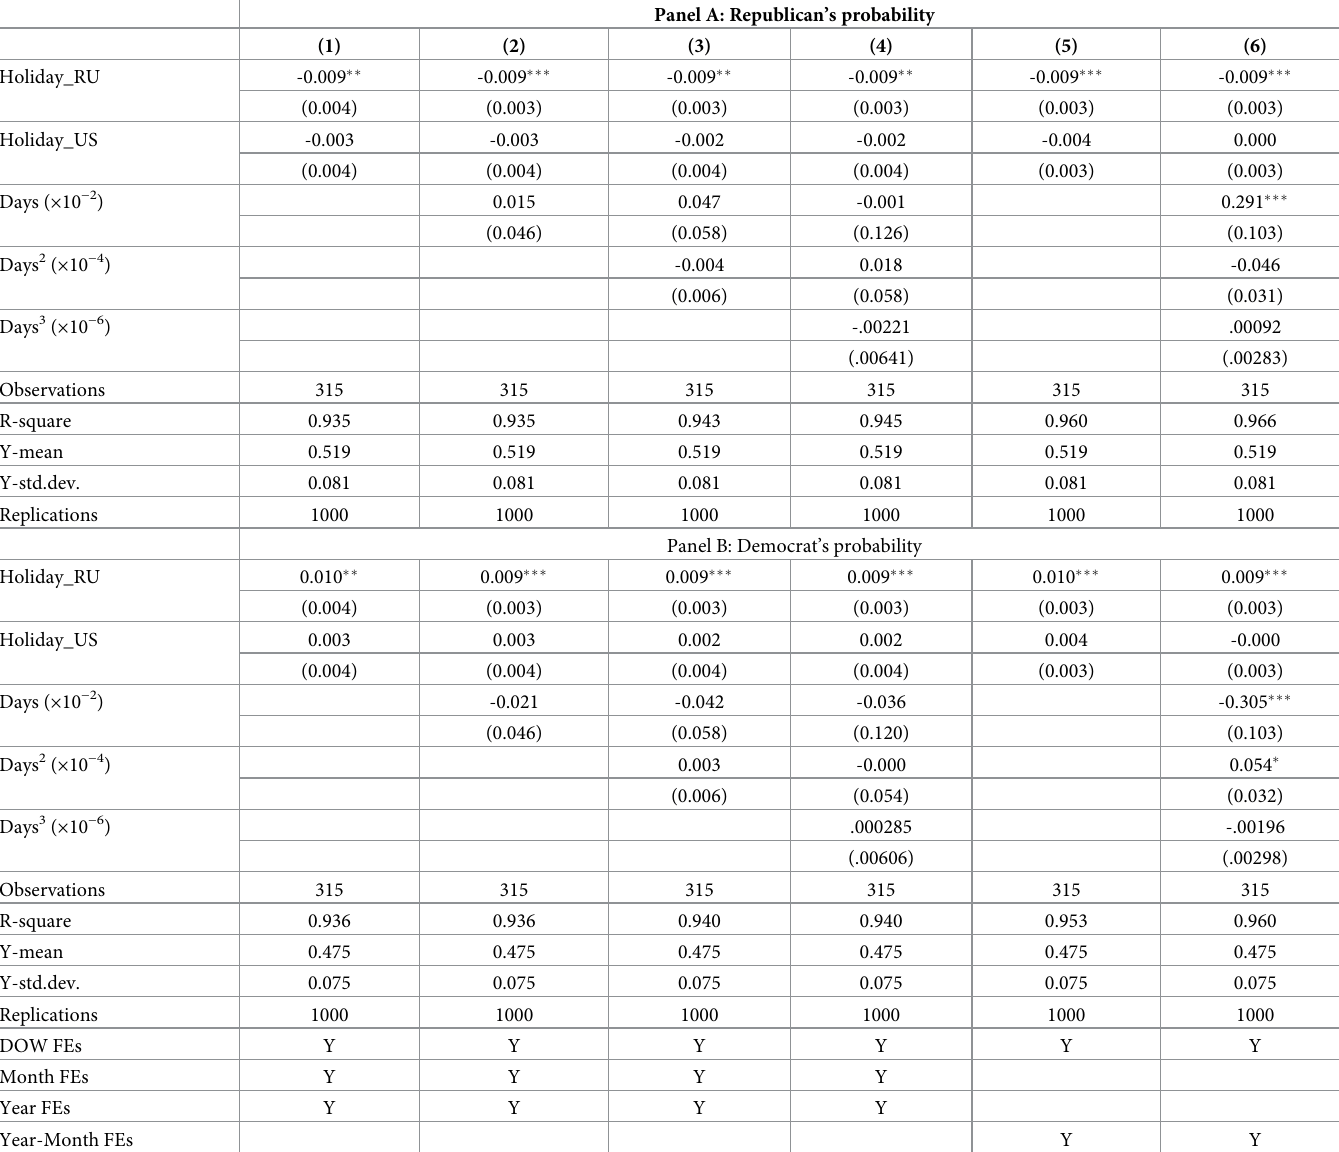
Table 2. Reduced form: Event study of PredictIt 2016 election odds around Russian holidays Nov. 2014–Nov.